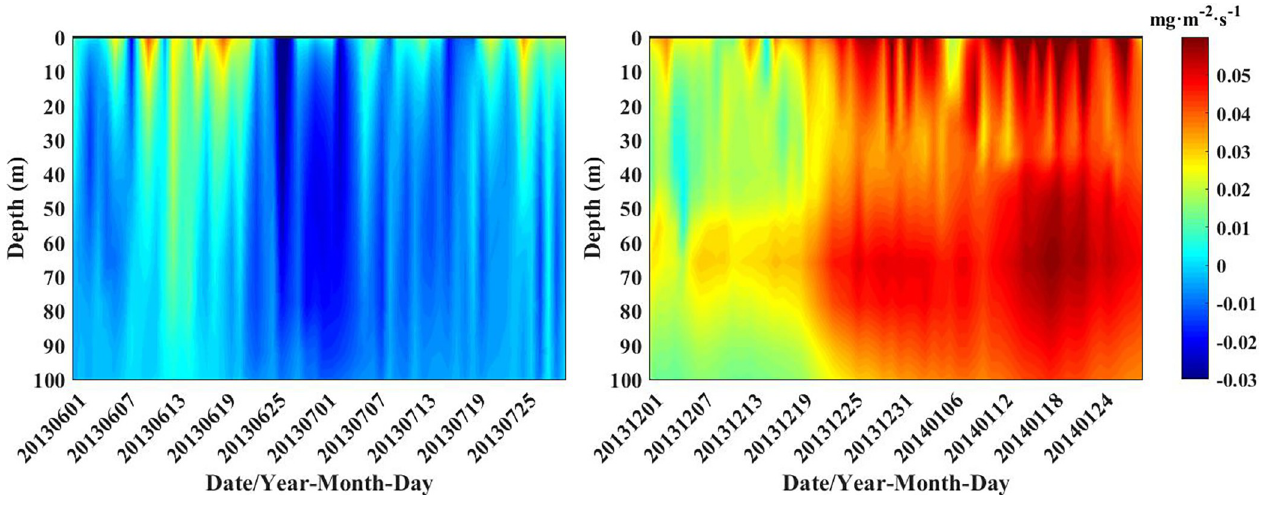
Fig 7. Time series of vertical distributions of Chl-a flux at the western boundary of Box B.